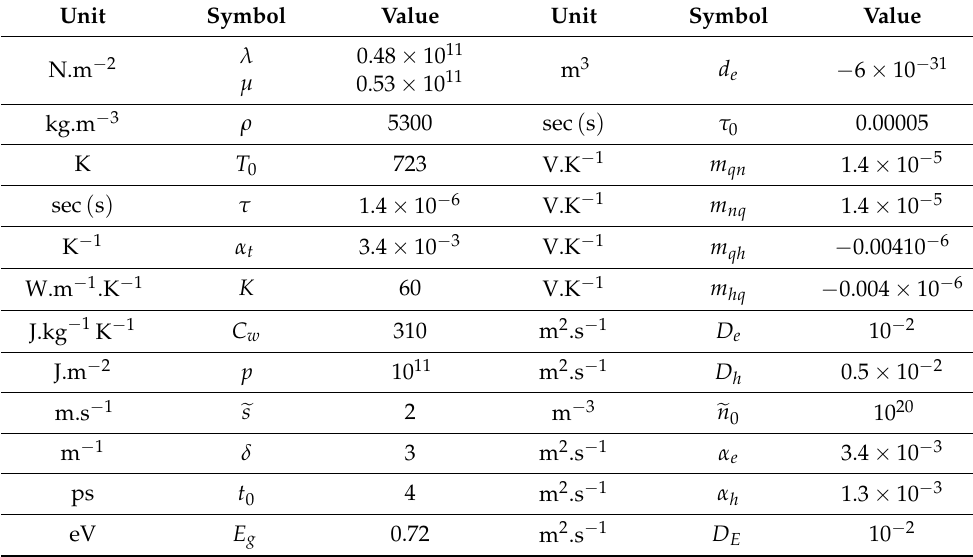
Table 2. The physical constants in SI units of Ge